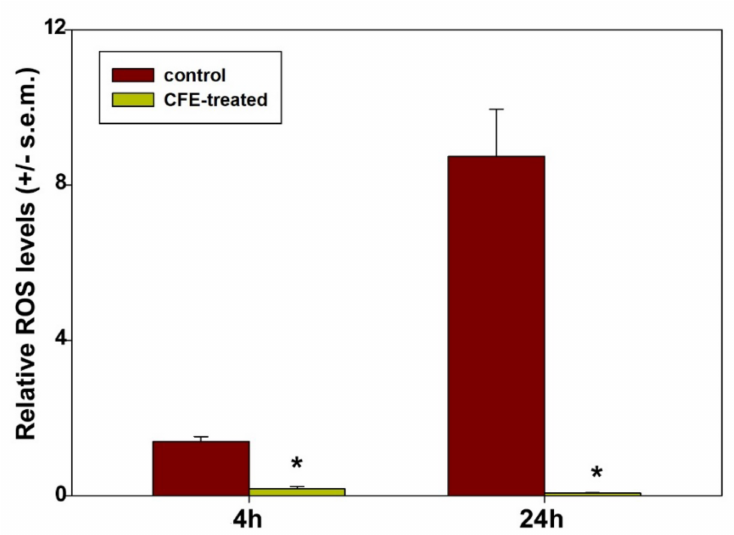
Figure 7. Bar graphs showing the ROS + cell/ROS − cell ratio in control and IC 50 24 CFE-treated HepG2 cells for 4 and 24 h. The error bars correspond to the standard error of the mean (s.e.m.) of three independent measurements. * p <